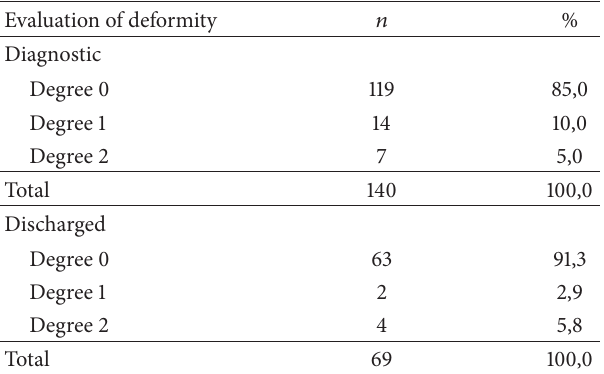
ment of only one nerve) and multibacillary (more than 05 lesions and involvement of more than one nerve). ∗∗ Clinical form based on the Madrid classification. ∗∗∗ Not performed: skin smear was not performed; ignored: the information is not available at SINAN. ∗∗∗∗ Referral: at referral centre; self-referred: patients report on their own to health centre; group examination: mass surveys and campaigns; contact examination: detection by examination of household